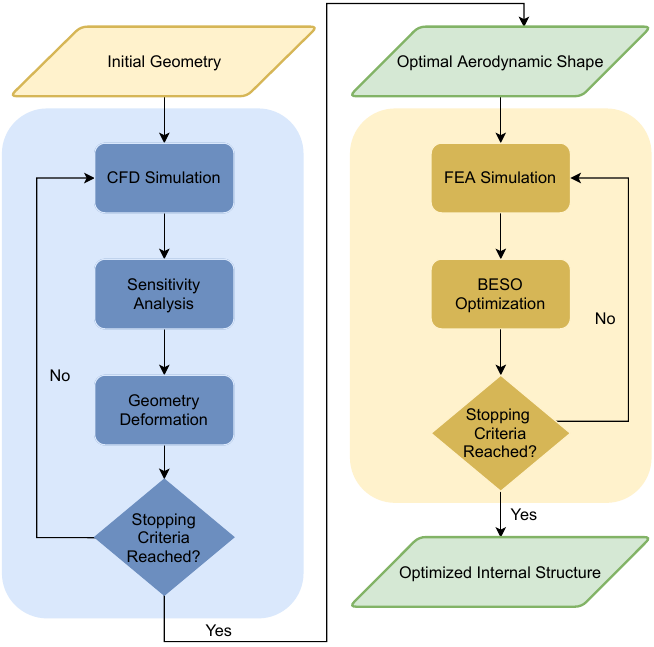
Figure 3. Sequential approach algorithm followed in this